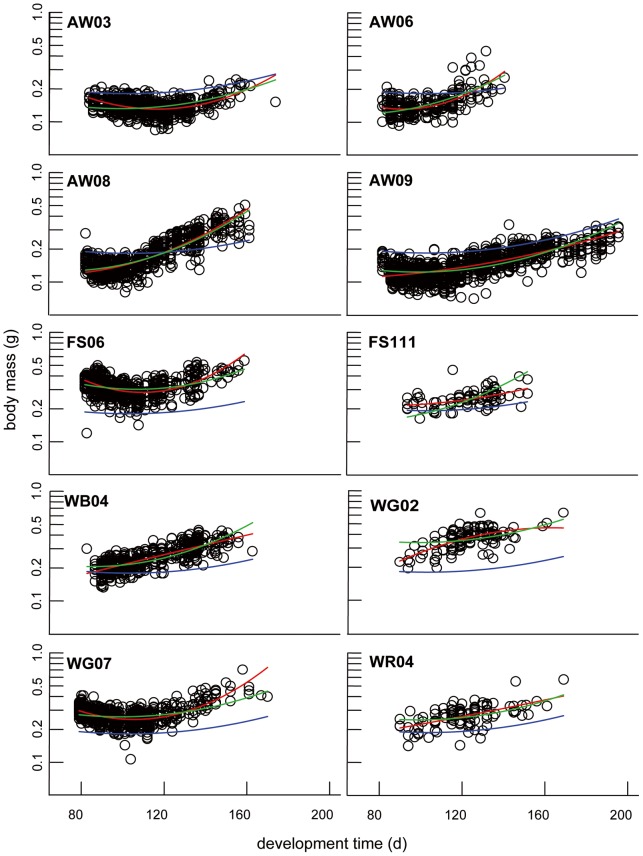
Emigration patterns of Rana temporaria metamorphs.Linear regression models describing R. temporaria metamorphic mass in relation to development time for the individual ponds were fitted in three approaches: first, all metamorphs irrespective of their emigration pond, resulting in an average regression for the studied population [blue line, log(mass) ∼ −0.83650 + (−0.01697× development-time) + (0.00008× development-time2)]. Second, regressions were calculated for each pond independently (red line, for exact description for regression parameters see Table S5). Finally, best linear mixed model according to model selection was used describing metamorphic mass over development time with the assessed environmental parameters (green line: log(mass) ∼ structuring-vegetation × development-time + inflow × development-time2, ‘pond’ was used as random factor (see Table 2).